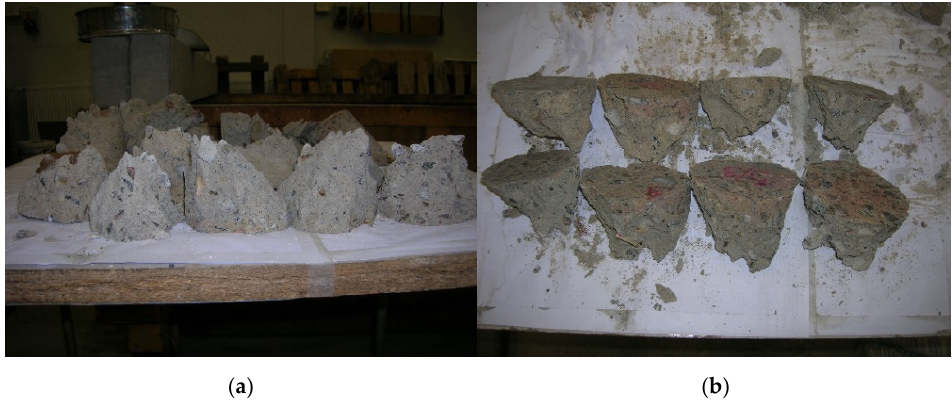
Figure 3. Concrete specimens after uniaxial compressive tests: ( a , b ) views of the form of failure. Table 3. Concrete compressive strength.